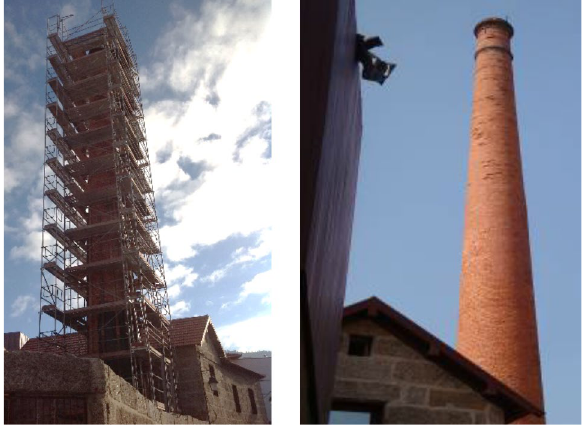
Figure 3. Structural intervention in the chimney: (a) view with the scaffolding for the works execution; (b) final